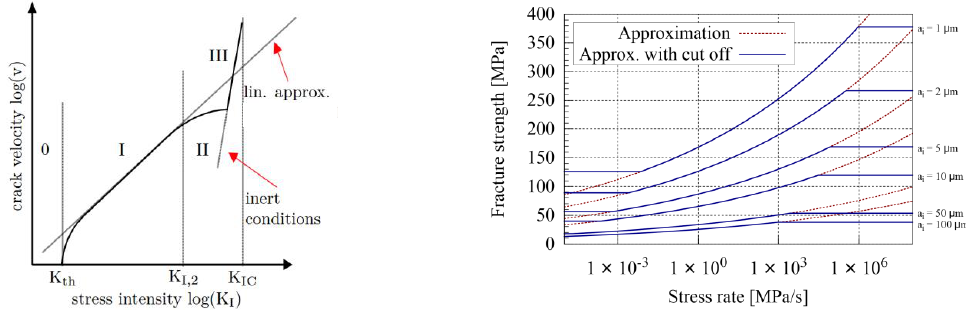
Figure 3. ( Left ) Different regions of subcritical crack growth velocity, cf. [11]. ( Right ) Fracture strength as a function of stress rate for different initial crack lengths, cf. [10]. An extension of Equation (6) by the cut off conditions from the Equations (7) and (8)